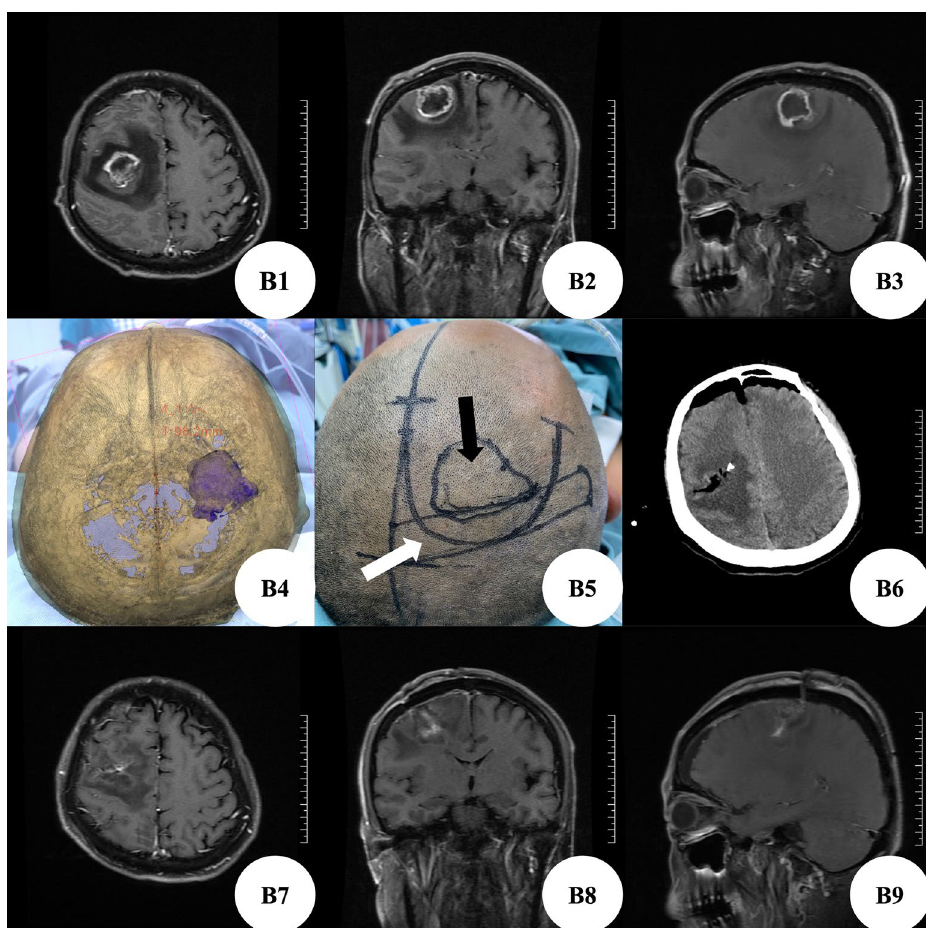
Figure 2. ( B1–B3 ) Enhanced brain MRI showed space occupying lesions in the right frontal lobe; ( B4 ) use the Apple mobile phone APP MosoCam for projection positioning; ( B5 ) the surgical incision was designed according to the projection location. The black arrow was the body surface projection of the tumor, and the white arrow was the body surface projection of the central anterior gyrus; ( B6 ) postoperative brain CT showed that the tumor was resected cleanly without delayed bleeding; ( B7–B9 ) on the 7th day after operation, brain MRI enhanced examination showed that there was no residual